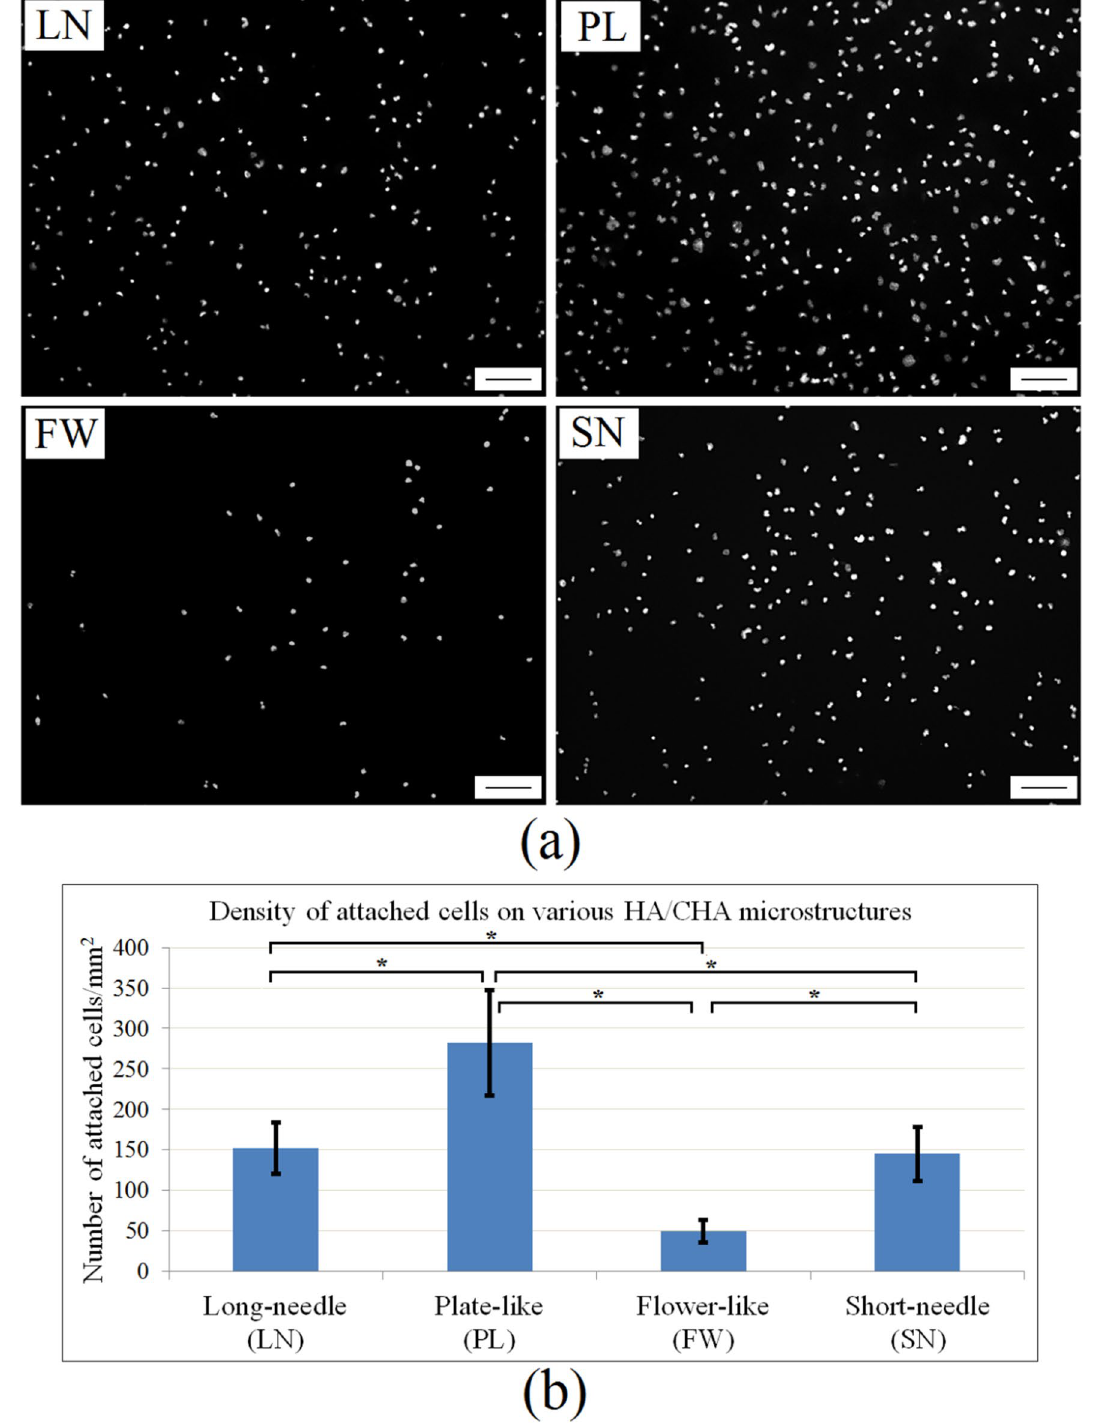
Figure 2. Number of cells attached to bioactive glass monoliths with different nanopore size and HA/CHA microstructure. Cell nuclei of MC3T3-E1 cells attached after 2 h to monoliths were stained with DAPI and imaged by fluorescence microscopy. ( a ) Representative black and white images of nuclei of attached cells on long-needle (LN), plate-like (PL), flower-like (FW), and short-needle (SN) HA/CHA-covered monoliths are shown (scale bar = 100 µm). ( b ) Density of cells attached onto the HA/CHA layer quantitatively determined by counting the number of cell nuclei per mm 2 on multiple representative images/monolith type in three independent experiments. Significant differences in cell numbers are marked with